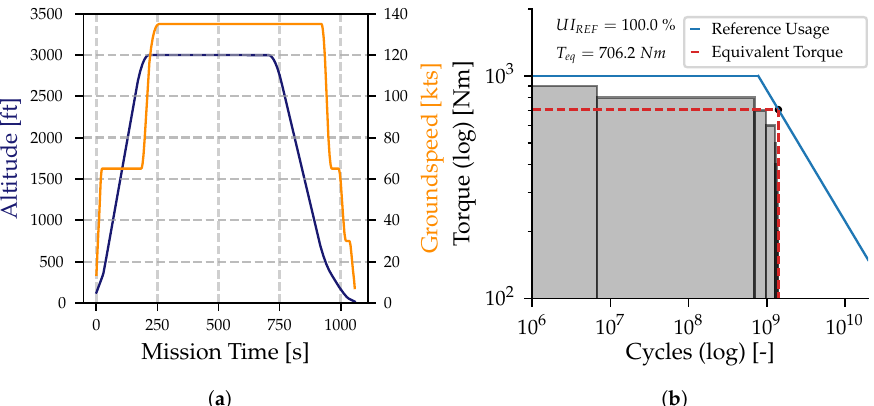
Figure 3. ( a ) Reference flight profile. ( b ) The derived usage reference curve (blue) with associated load spectrum (grey).